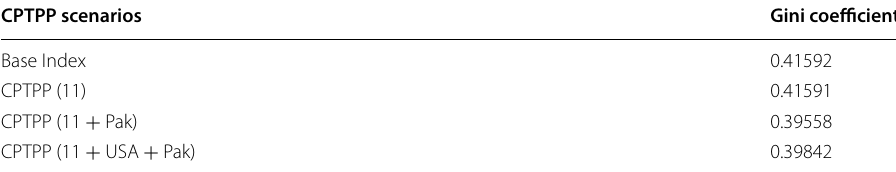
Table 9 Impact on Income Inequality in Pakistan Source : Author’s